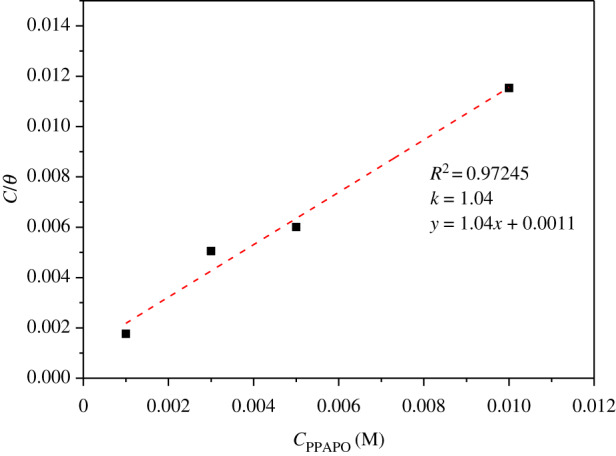
c/θ ∼ c plots in different concentration of PPAPO and 3 mM Na2WO4 at 333 K.